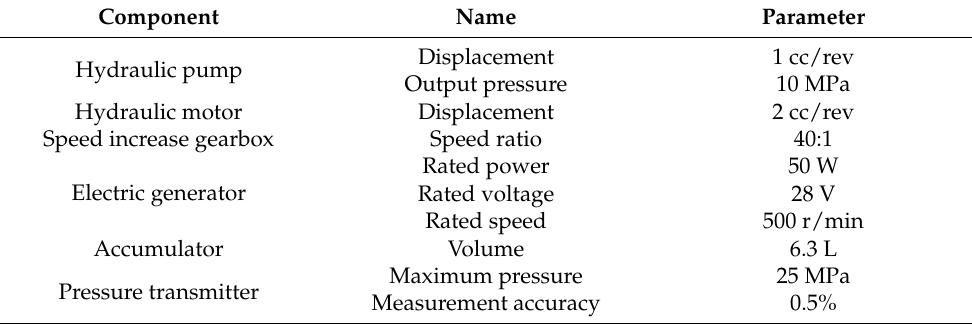
Table 1. The parameters of hydraulic PTO system